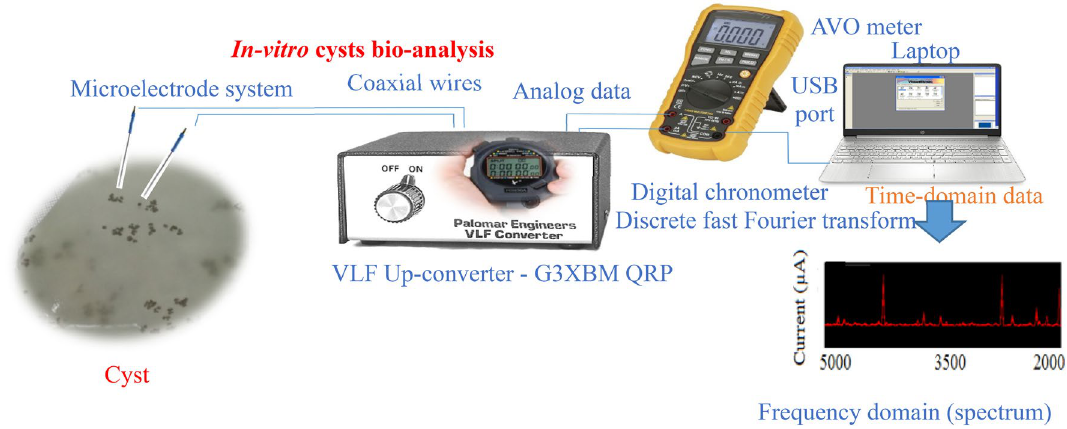
Figure 1. Schematic of the designed and introduced instrumentation system for cyst bio-analysis process.